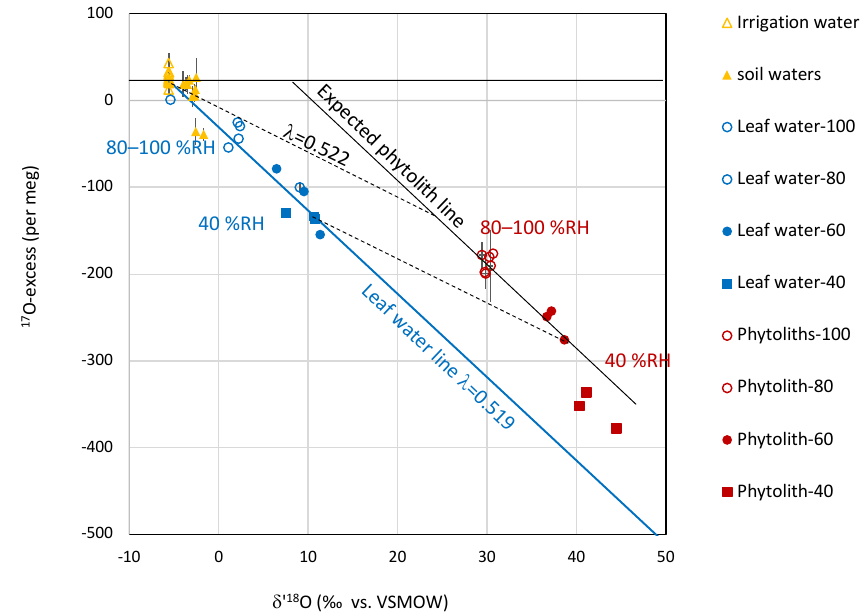
Figure 6. Growth chamber experiment: 17 O-excess vs. δ (cid:48) 18 O of irrigation water (IW), soil water (SW), bulk leaf water (LW) and phytolith (Phyto). Error bars show standard deviation (SD) on the replicates. The leaf water line (blue) represents how the triple oxygen isotope composition of the bulk leaf water of Festuca arundinacea evolves from an irrigation water signature to a more evaporated water signature when RH decreases. Assuming that phytoliths precipitate from the bulk leaf water, the expected phytolith line (black) should be parallel to the leaf water line as the equilibrium fractionation between phytolith and leaf water is constant at constant temperature (25 ◦ C). In the investigated case this fractionation, represented by the black dotted line, is equivalent to λ = 0 . 522 (Table 1). The isotope signature of phytoliths formed at RH higher than 40% follow the expected phytolith line. However, the isotope signature of phytoliths formed at 40% RH suggest a forming water more evaporated than the bulk leaf